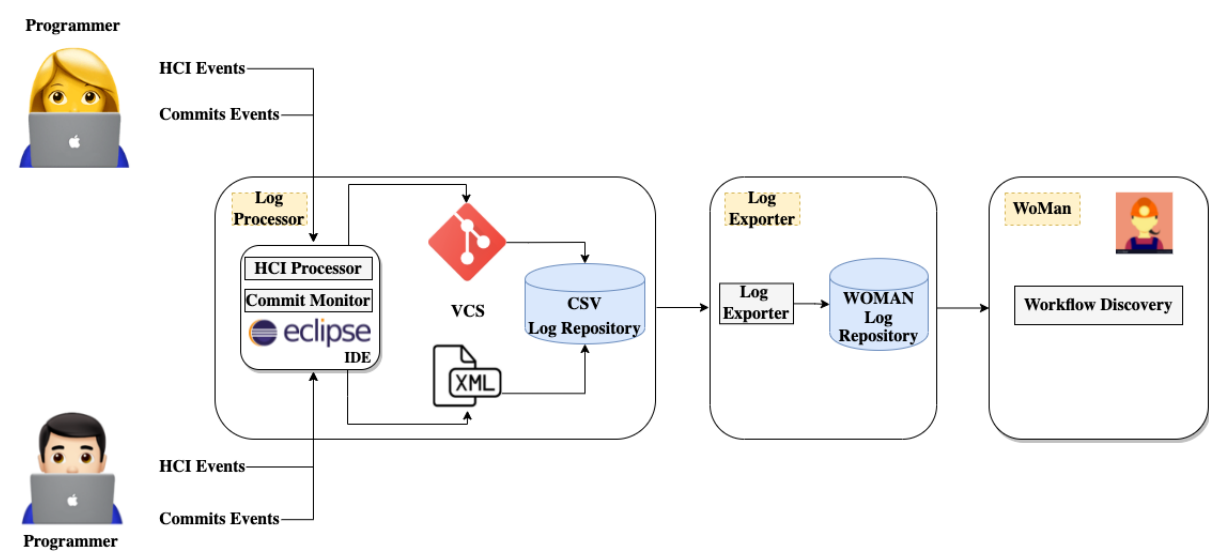
Figure 1. The environment